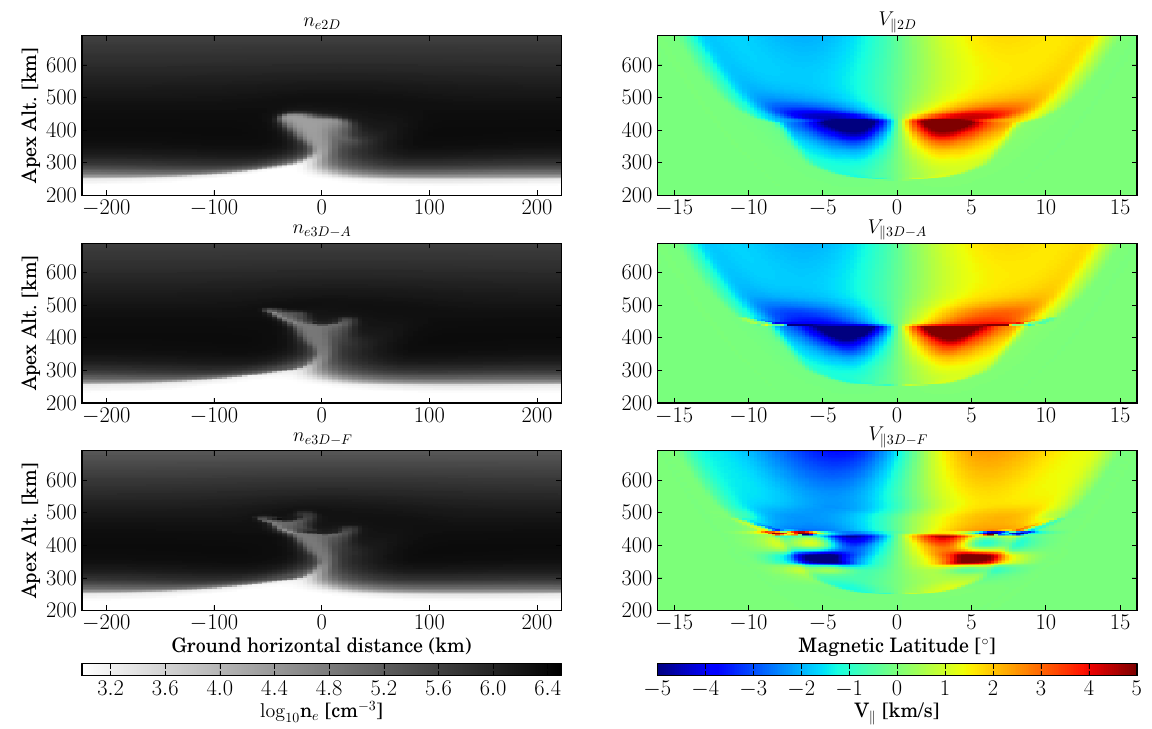
Fig. 2. Plasma conditions at the end of the simulation ( t ∼ 21:00LT): (left) plasma densities in a cut through the equatorial plane and (right) O + ion parallel velocities in a cut through the meridional plane. From top to bottom, the solutions using the 2-D, 3-D-A, and 3-D-F models,